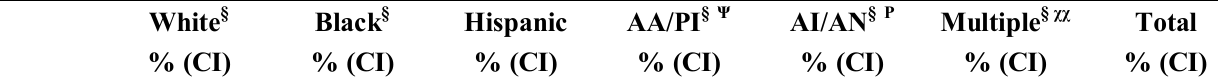
Table 2. Proportion of Smokers Ф who reported a quit attempt in the past year by race/ethnicity and selected smoking